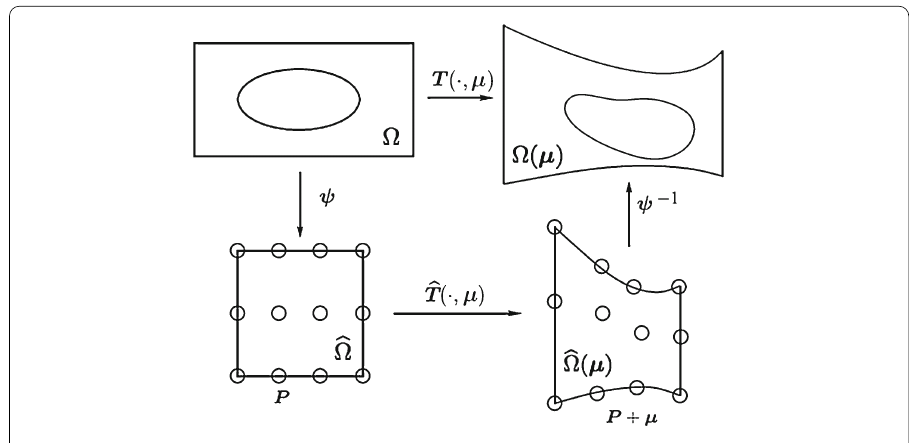
Fig. 4 Sketch of the FFD map construction. For ease of readability we dropped the superscript from μ